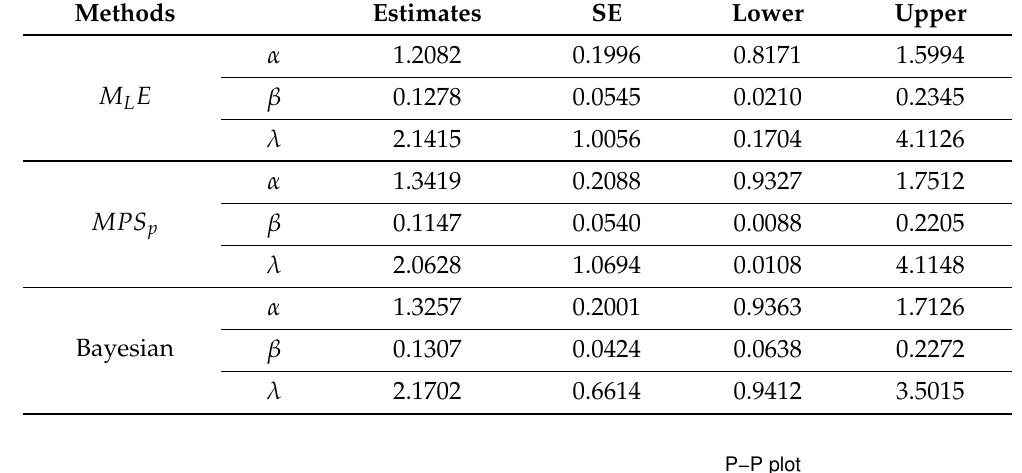
Table 6. M L E , MPS p , Bayesian estimation methods for the recovery rate of COVID-19 data from Turkey.